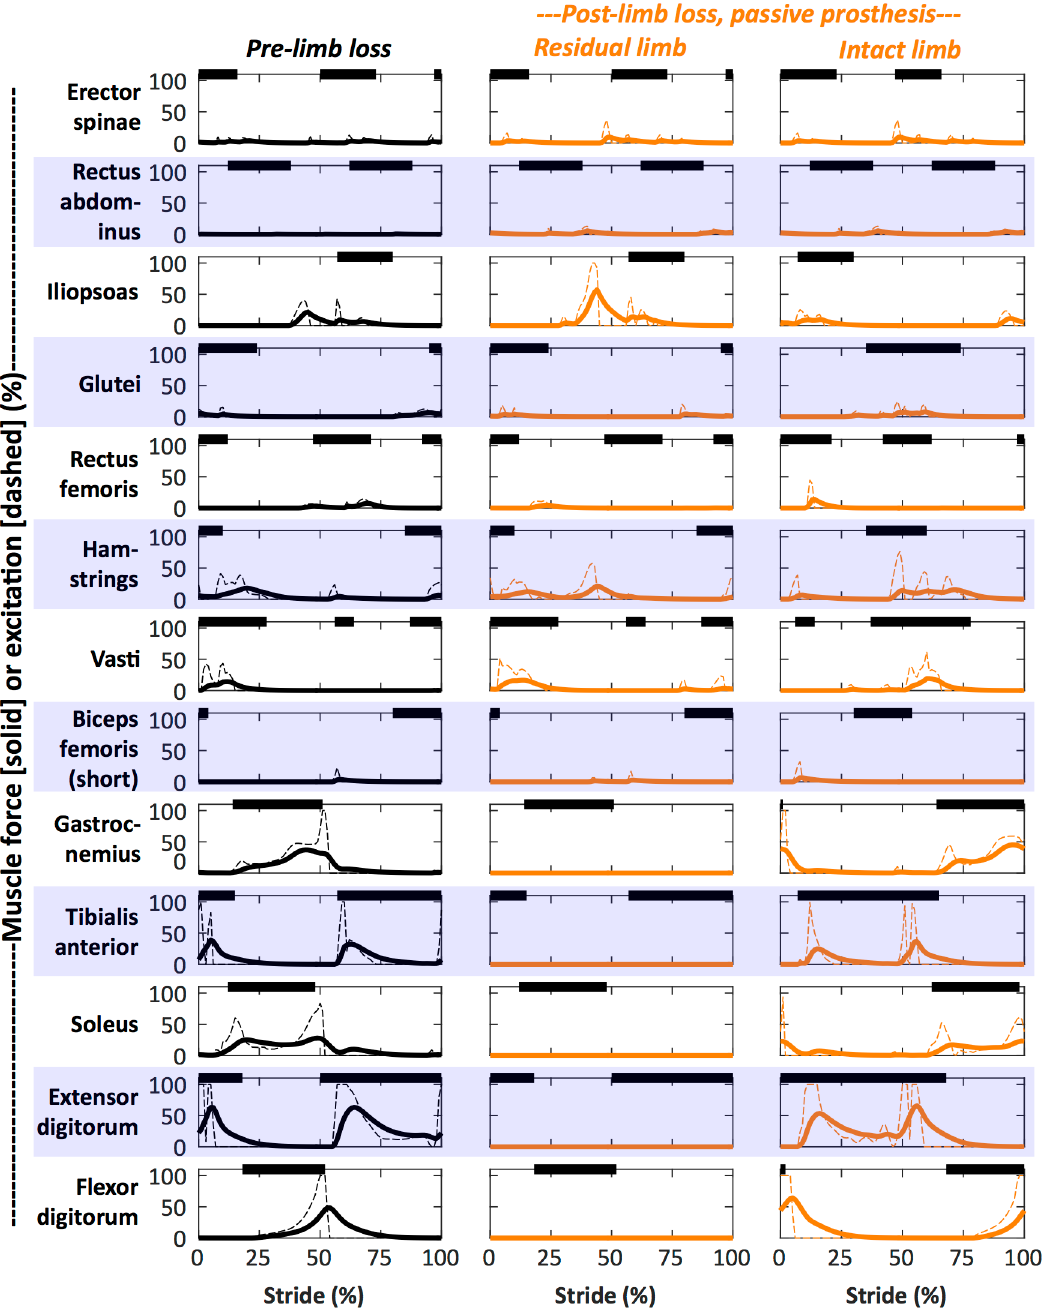
Fig 5. Example muscle forces and excitations. Muscle forces (solid lines, % max isometric force) and excitations (dashed lines) of Subject 01’s walking simulations with the pre-limb loss model (column 1) and with the post-limb loss model using the passive prosthesis (columns 2 and 3). The post-limb loss model had no strength loss. The stride begins at heel-strike of the right/residual limb. The thick bars at the top of each panel are typical “on/off” timing derived from experimental electromyograms [43,44].